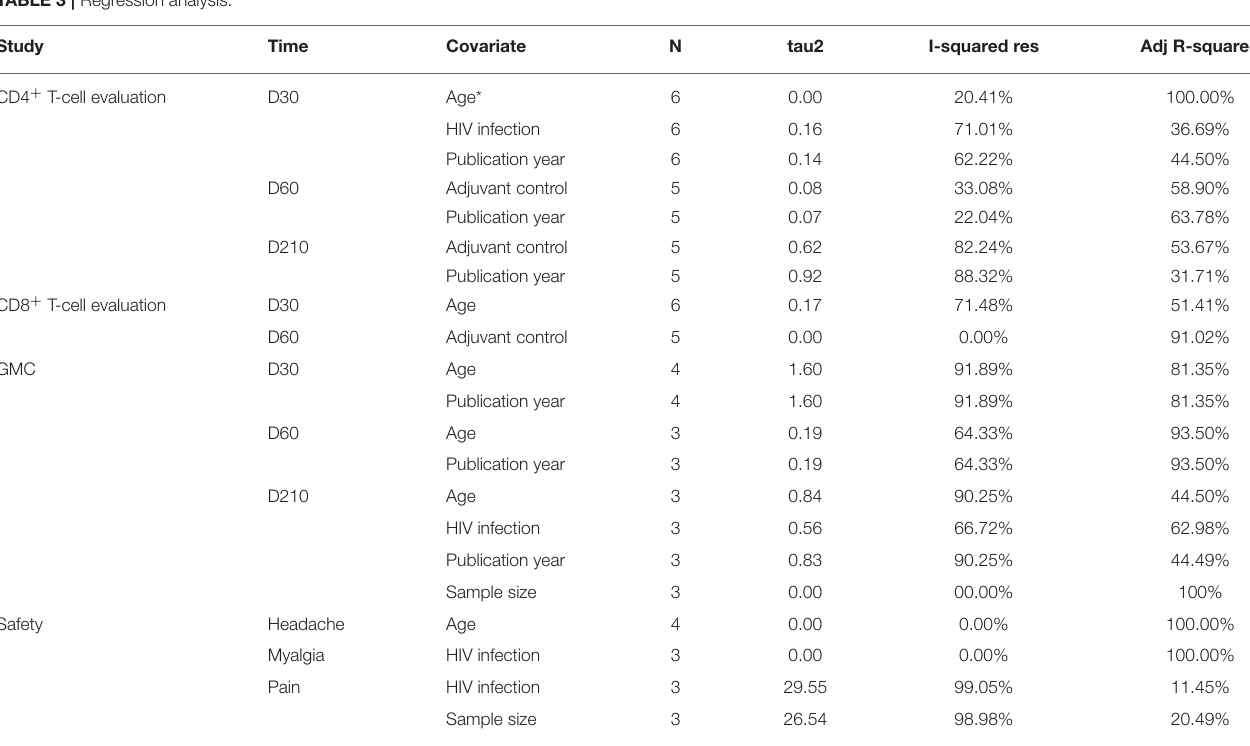
TABLE 3 | Regression